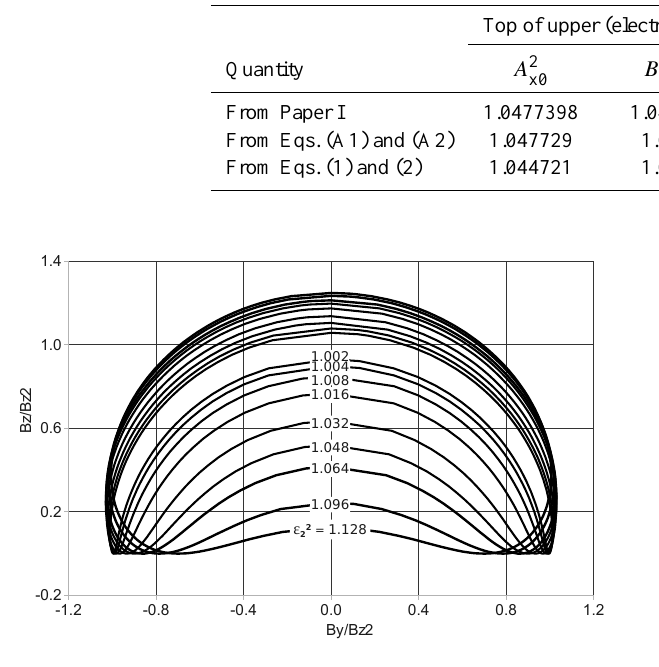
Fig. B1. Magnetic hodograms similar to Fig. 1, but for a fixed field = (A 2 − 1 ) . Parameter values used rotation and larger values of (cid:15) 2 2 x2 are γ = 2 and β 2 = 1, which gives u 2 = 1 regardless of θ 2 . Fig. B2. Top panel: maximum field deviation, B dev − 1 = B t 0 /B z2 − q − 1. Results from Fig. B1 are shown A 2 1 as a function of (cid:15) 2 = x2 as solid curves, theoretical values from Eq. (2) as dashed lines, and results from Eq. (A2) as dotted curves. Red color indicates ion po- larization, blue color electron polarization. Bottom panel: disconti- nuity thickness (in units of the ion inertial length) as a function of (cid:15) 2 . Red curves are for ion polarization, blue for electron polariza- tion. The grey curve is the prediction from Eq. (5). Parameter values used are the same as in Fig.